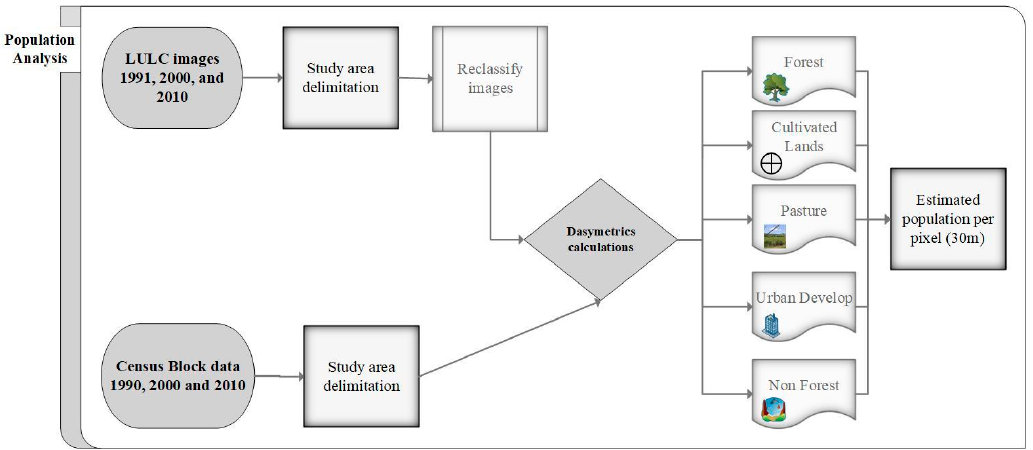
Figure 2. Census data analysis to create a dasymetric map.